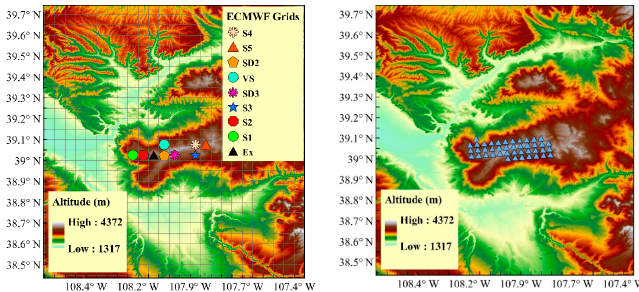
Figure 1. Topographic map of Grand Mesa with ECMWF grid cells (overlain grid on the left panel) and 43 grid points from the HRRR model (triangles on the right panel). Snowpit locations from the SnowEx’17 field campaign are clustered into nine groups corresponding to individual ECMWF grid cells (~5 × 5 km 2 ) marked on the left panel. Each cluster contains at least eight snowpits. Table S1 in Supplementary Information provides the central (latitude, longitude) coordinates for each grid. The coordinates of the HRRR grids are fully or partially within the corresponding ECMWF